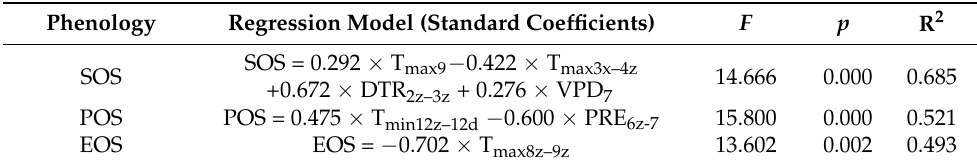
Table 1. Parameters of stepwise regression for phenology and climatic factors in critical periods. Phenology